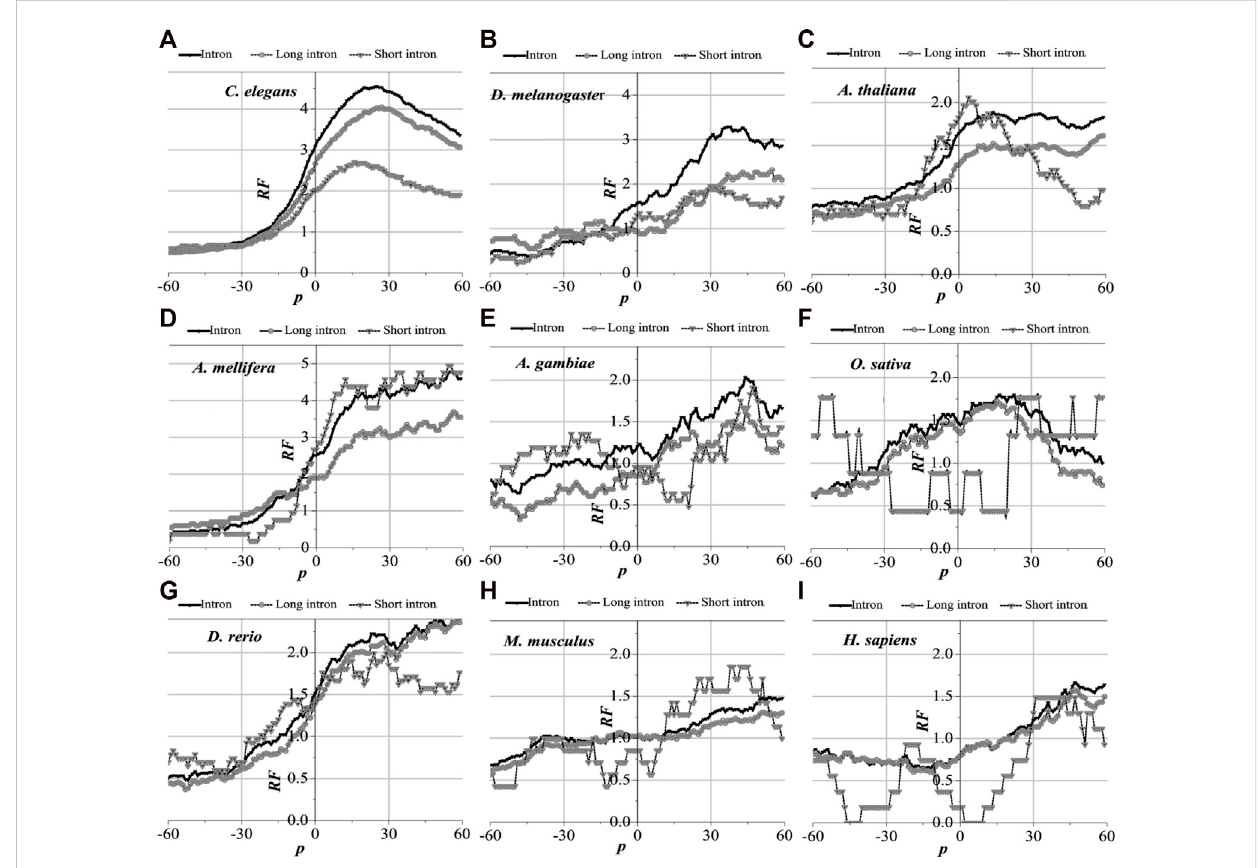
FIGURE 5 RF distributionsaroundtranslationterminationsite.TheX-axisisthepositionofmRNAandtheY-axisrepresentsthe RF values. RF =1representsthe average value of relative match frequencies